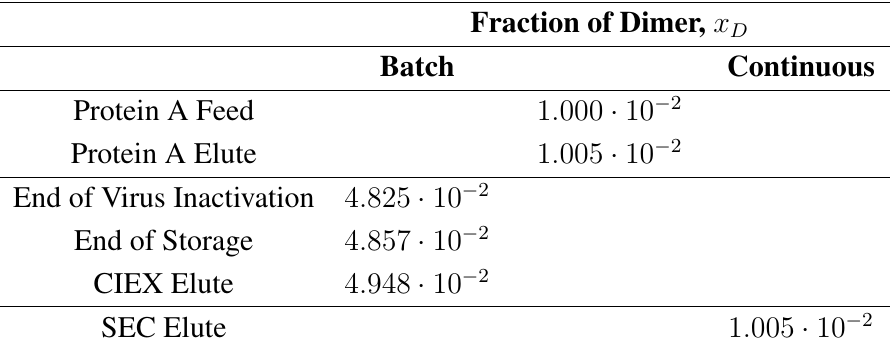
Figure 2. Simulated protein A capture chromatogram. As identical conditions are used, identical chromatograms were obtained in the batch-wise and continuous processes. The solid line ( − ) is the total concentration of antibodies in the eluate from the column, (cid:80) C ( t, z = L ) , and the dashed lines ( −− ) the cut points for pooling. T,i i ∈{ M,D } Table 1. The massfraction of dimer, x , after the different unit operations in the batch D and continuous processes. The values for cation-exchange chromatography (CIEX) and ize-exclusion chromatography (SEC) elute are the integral mean of the total dimer fraction in the column outlet, i.e. , not the dimer fraction in the